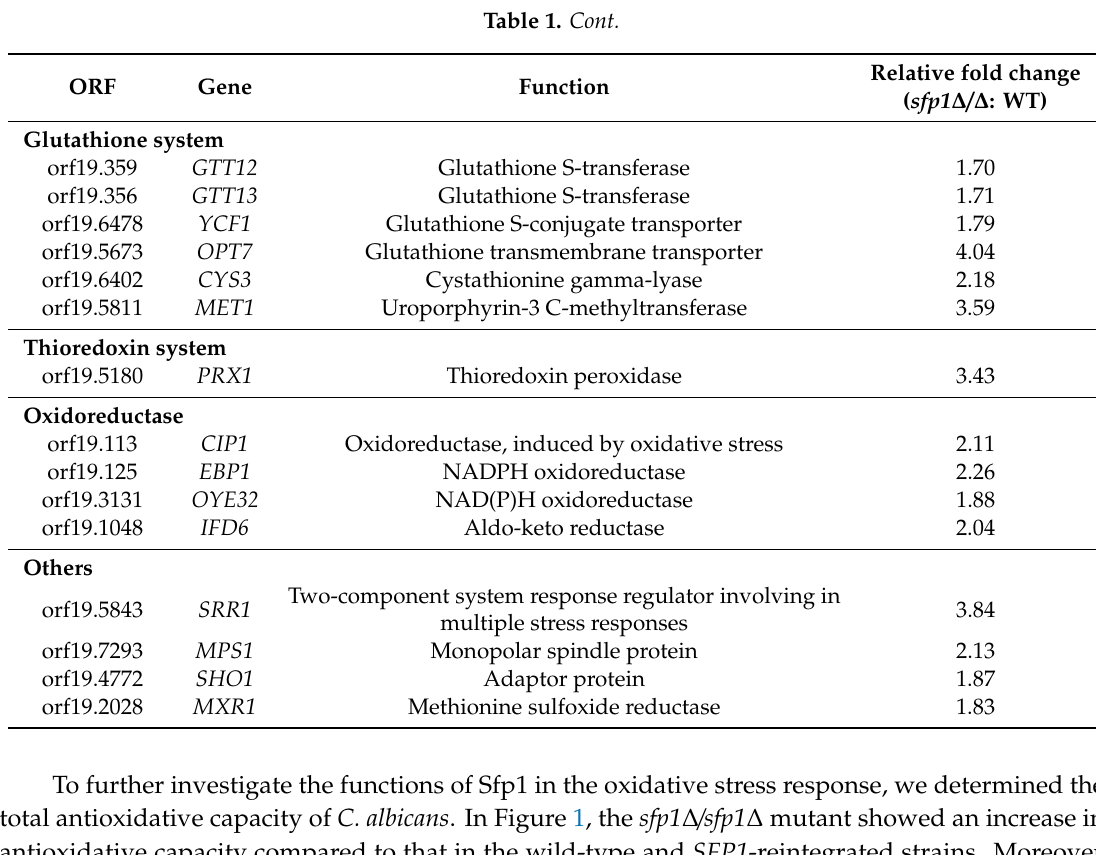
Table 1. Relative expression of oxidative stress response genes in th e sfp1 -deleted vs wild-type strains. (P < 0.05). ORF Gene Function